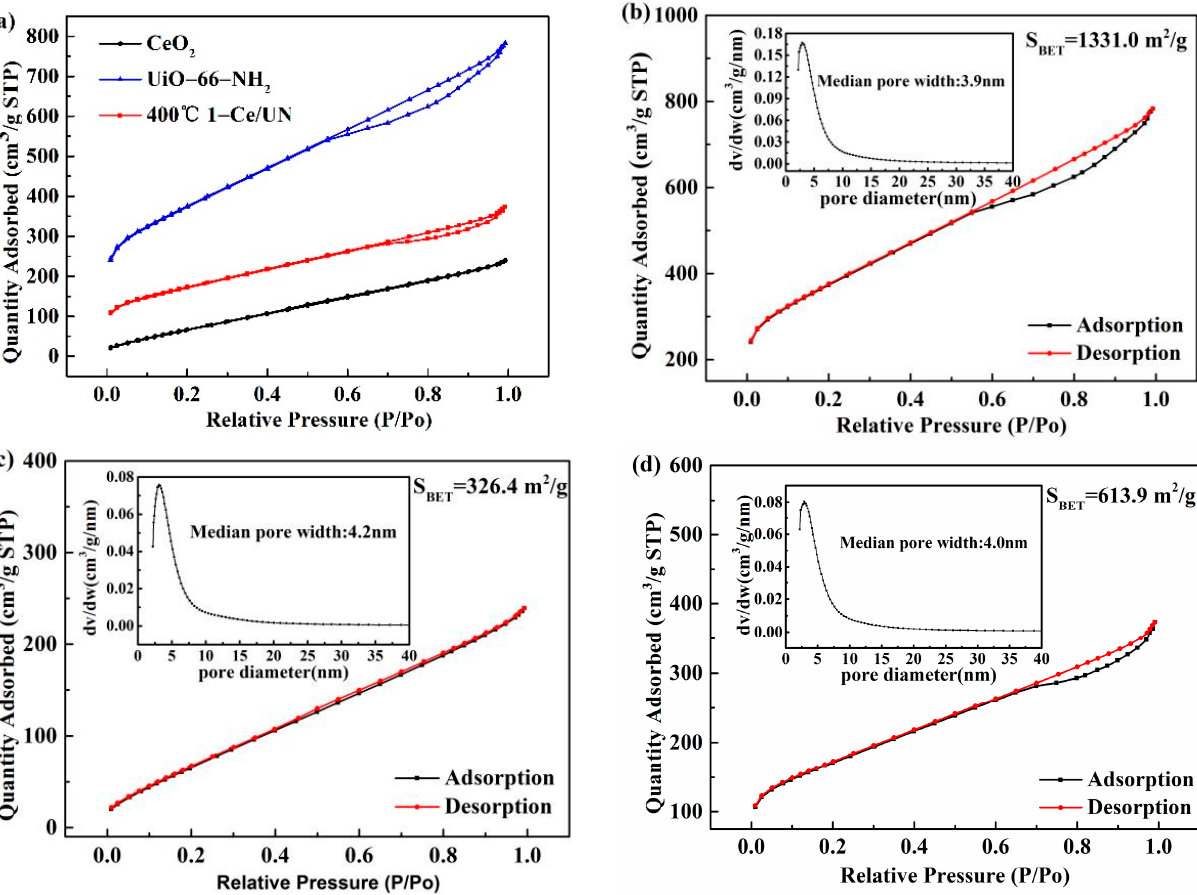
Figure 12. ( a ) N 2 adsorption–desorption isotherms of CeO 2 , UiO-66-NH 2 and 400 ◦ C 1-Ce/UN; ( b ) N 2 adsorption–desorption isotherms and the pore size distribution of UiO-66-NH 2 ; ( c ) N 2 adsorption–desorption isotherms and the pore size distribution of CeO 2 ; ( d ) N 2 adsorption–desorption isotherms and the pore size distribution of 400 ◦ C 1-Ce/UN.